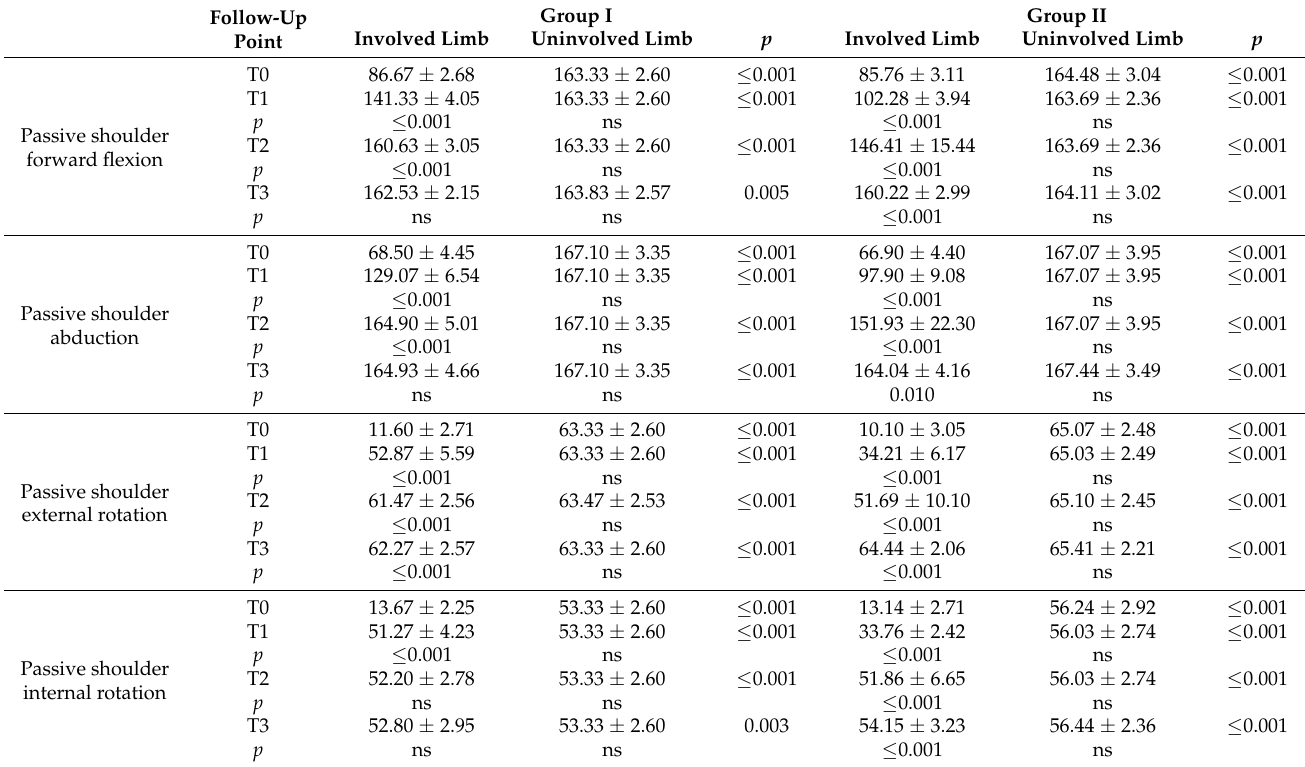
Table 1. The within-group comparison of the obtained values of shoulder range of motion expressed in degrees. Follow-Up Point